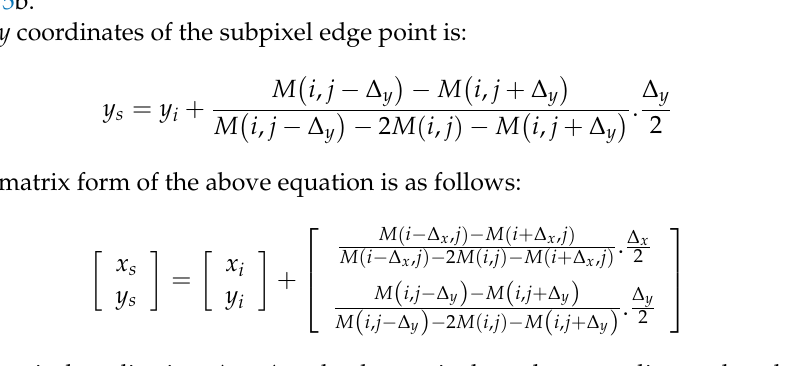
Figure 5. The schematic diagram of interpolation method. ( a ) The interpolation along x axis. ( b ) The interpolation along y axis. ( c ) The gray level of the interpolation point.